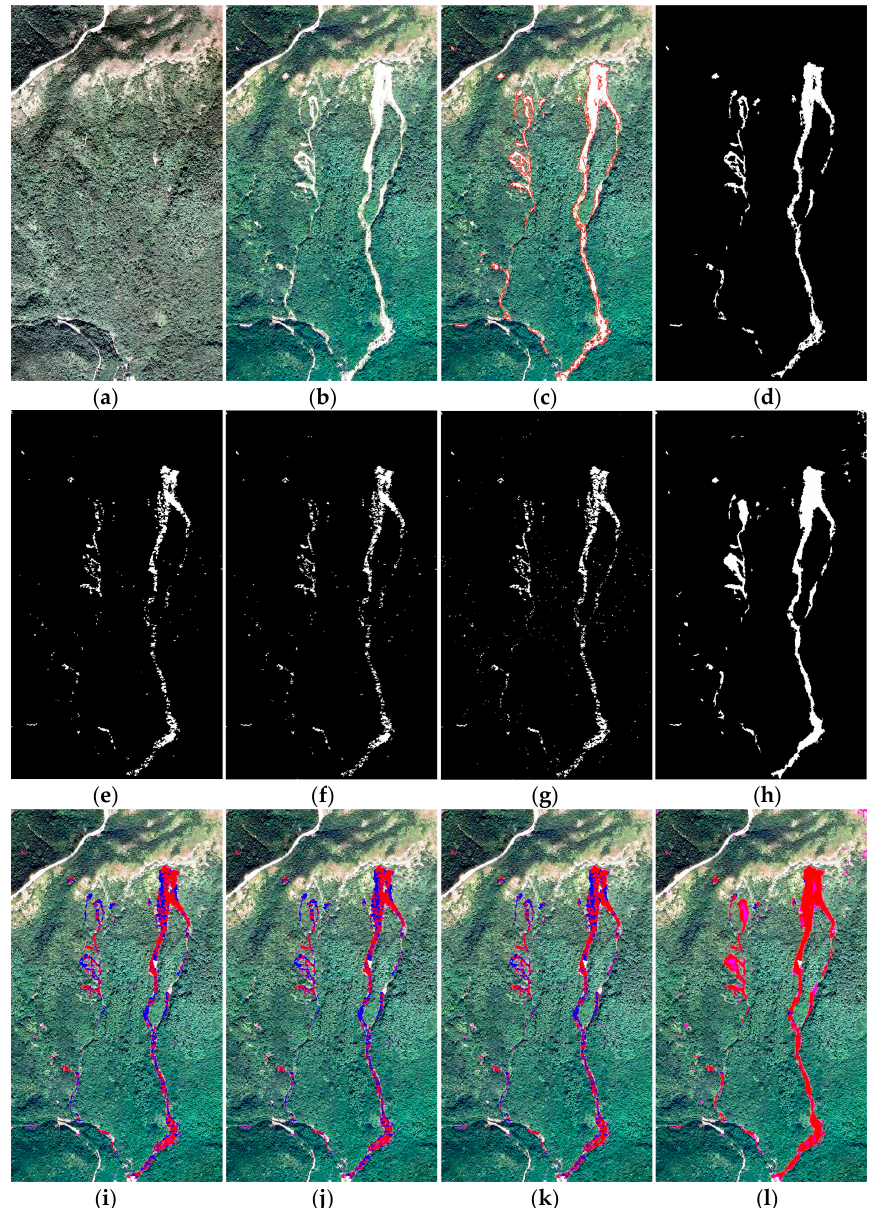
Figure 13. Experimental results on A-area: ( a) pre-event image; ( b ) post-event image; ( c ) contour of ground truth on post-event image; ( d ) ground truth segmentation; ( e ) landslide regions obtained by ELSE; ( f ) landslide regions obtained by RLSE; ( g ) landslide regions obtained by CDMRF; ( h ) landslide regions obtained by the proposed CDFFCM; and ( i – l ) landslide mapping results using ELSE, RLSE, CDMRF, and CDFFCM overlaid on the post-event image, respectively.